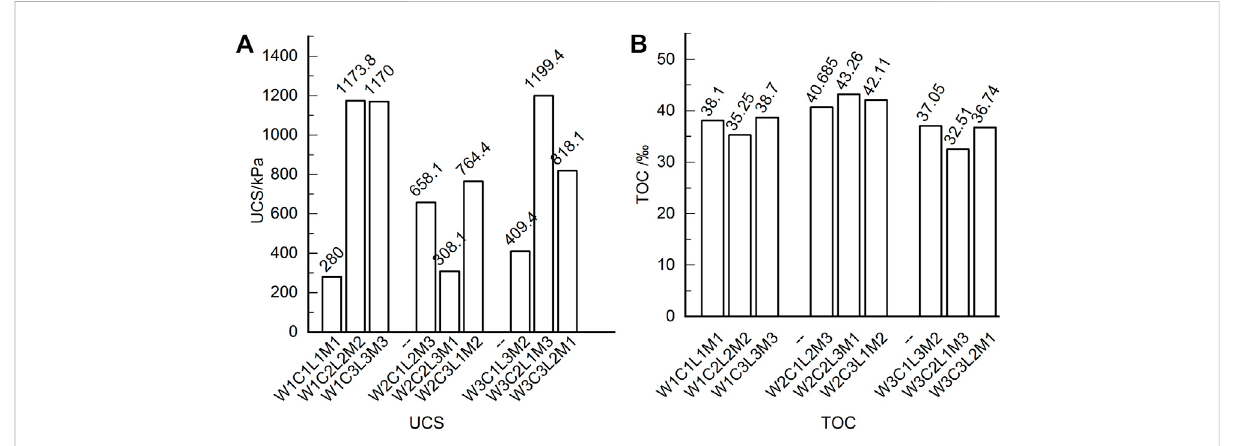
FIGURE 2 UCSs and TOCs of S/S sediments at the 28th day: (A) UCS, (B) TOC.